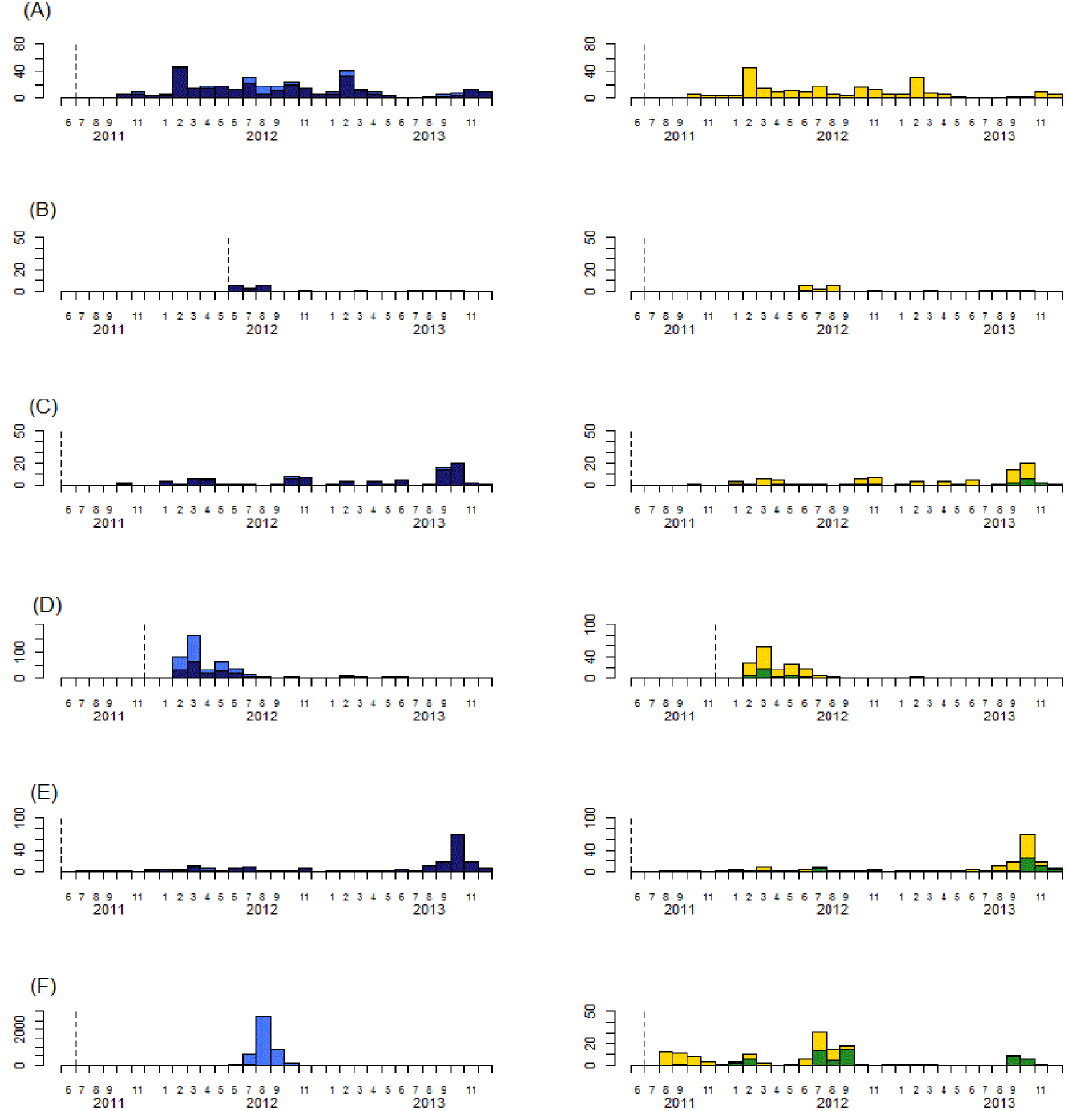
Fig 1. Suspect cases with culture done and Suspect cases with positive culture for Vibrio cholera (first part). Surveillance zone, Beira city, Mozambique (A); surveillance zone, Koumassi-Vridi-Port Boët district, Abidjan, Cote d ’ Ivoire (B); surveillance zone, Lake district, Togo (C); surveillance zone, Mbale-Manafwa-Butaleja districts, Uganda (D); surveillance zone, Lome-Golfe districts, Togo (E); surveillance zone, Conakry, Guinea (F); Dark blue bars show cases with culture test done, light blue bars show cases with culture test not done, green bars show cases with Vibrio cholera identified by culture, and yellow bars show cases having a culture negative for Vibrio cholera . The dashed line shows the first month of the enhanced Africhol surveillance. The dotted line shows the last month of the enhanced Africhol surveillance.